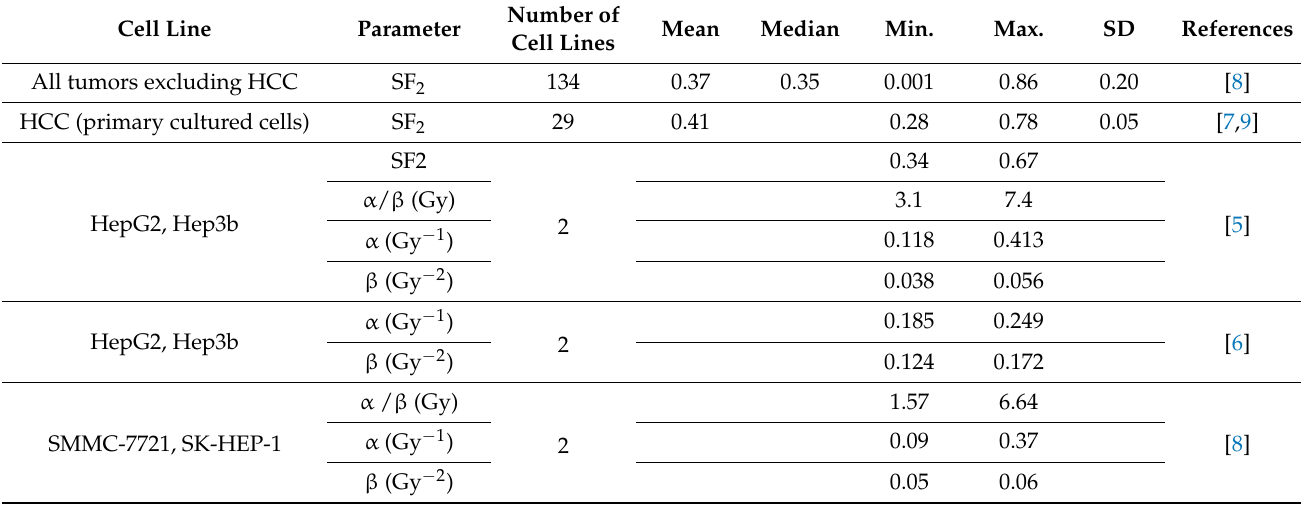
Table 1. Hepatocellular carcinoma radiosensitivity described in terms of SF2 and LQ parameters. Cell